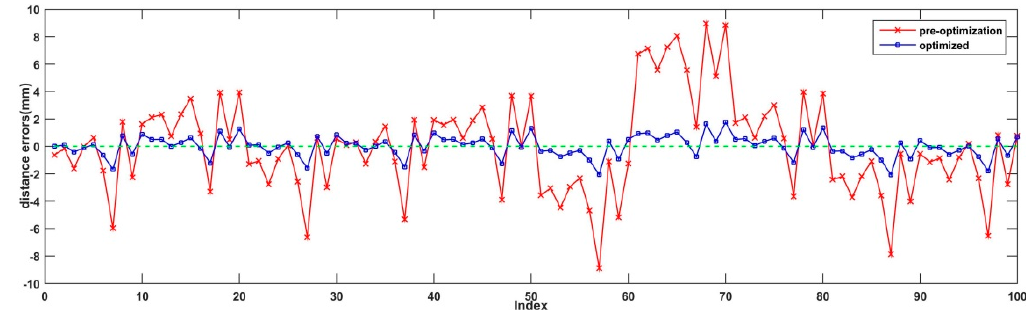
Figure 5. Distance error curves before and after bundle adjustment.